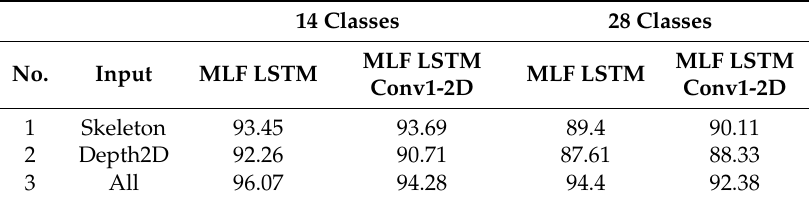
Table 8. Overall performance